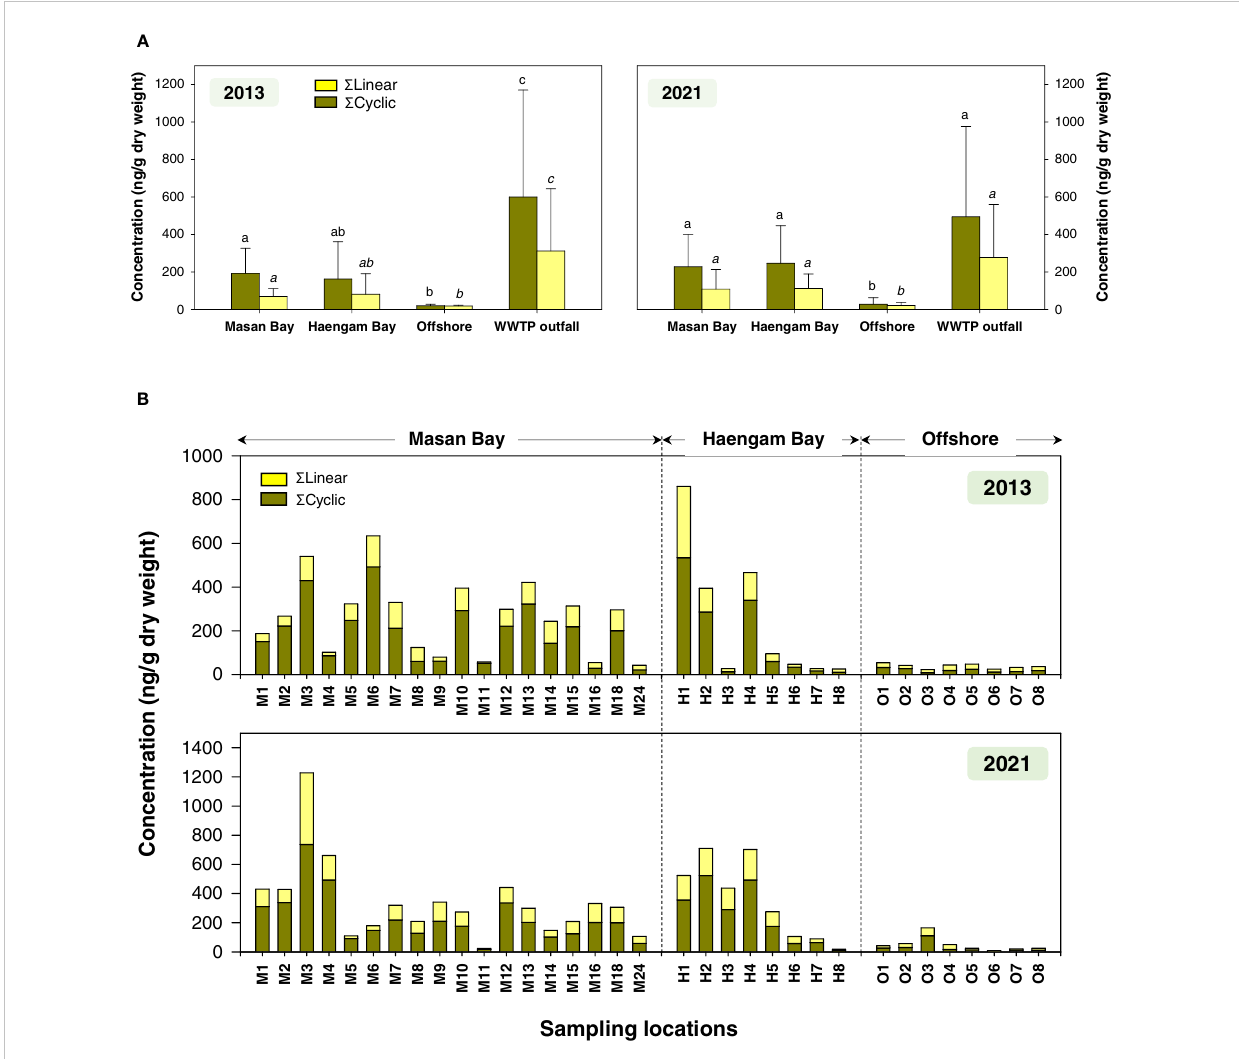
FIGURE 2 The spatial distribution of cyclic and linear siloxanes in sediment from Masan and Haengam Bays of Korea and around the submarine outfall of a wastewater treatment plant collected in 2013 and 2021. (A) Concentrations of cyclic and linear siloxanes in sediment from four coastal zones in our study collected in 2013 and 2021. (B) Concentrations of cyclic and linear siloxanes in sediment from each sampling locations collected in 2013 and